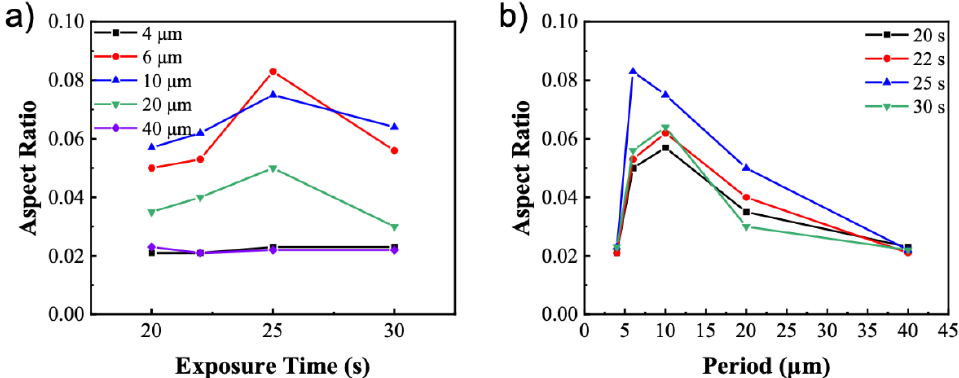
Figure 4. Aspect ratio of the photo-embossed structures as a function of ( a ) UV exposure time for different periods and ( b ) period of photomask for different exposure times. different periods and ( b ) period of photomask for different exposure